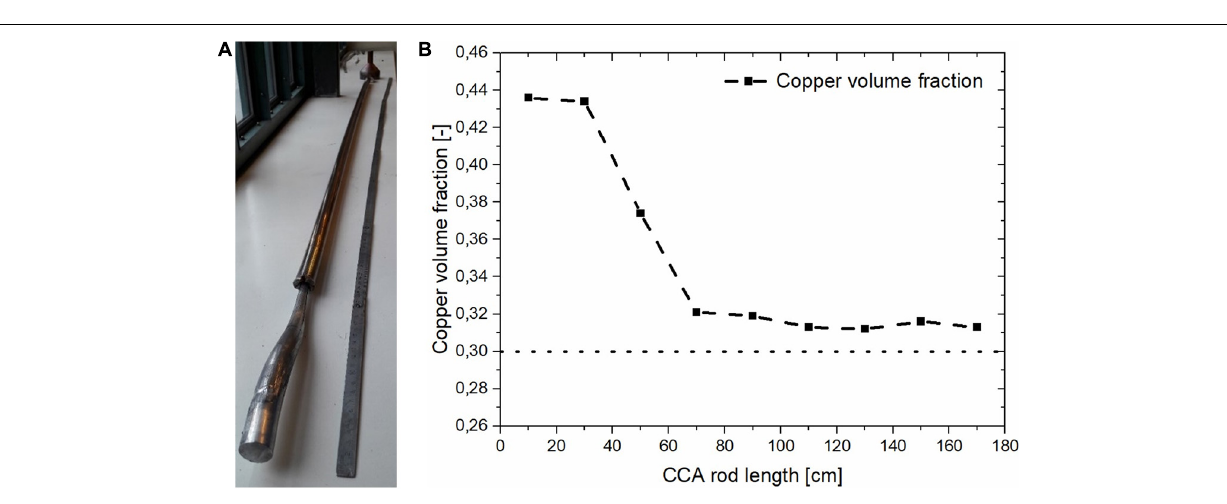
FIGURE 10 | (A) Extruded CCA rod and (B) evolution of the copper volume